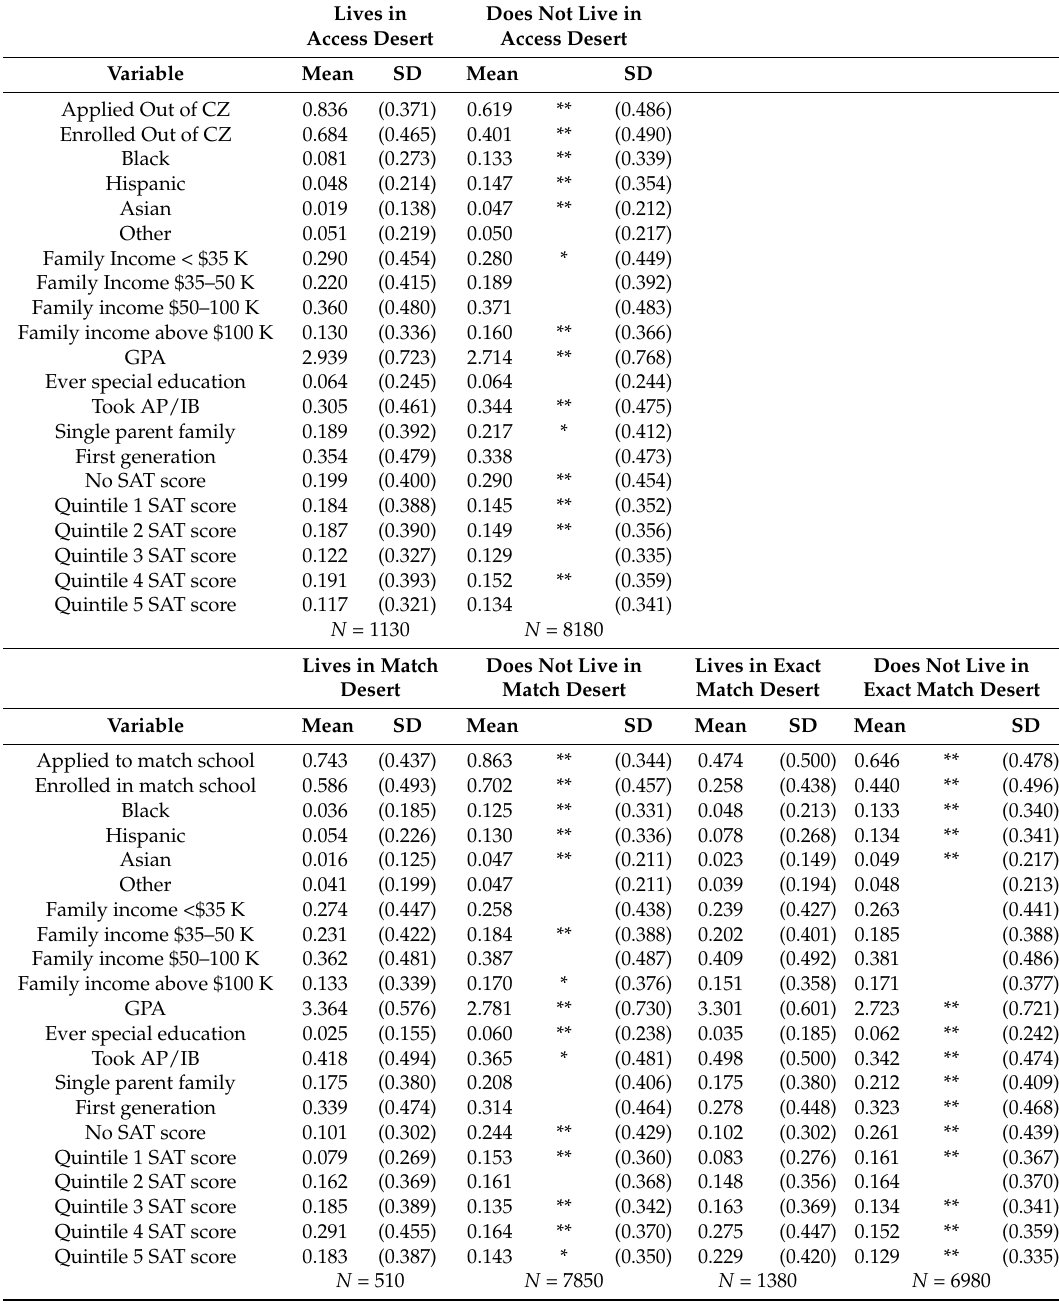
Table 1. Descriptive statistics of students by education desert